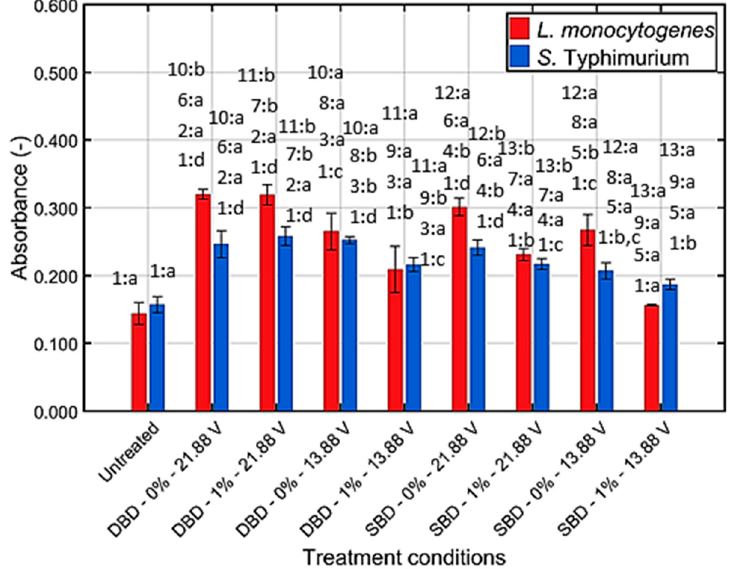
Figure 7. Absorbance measurements (-) obtained following CAP treatment of the Listeria monocytogenes and Salmonella Typhimurium model biofilms ( n = 3). Significant di ff erences between all examined conditions (ANOVA test 1), including the untreated control, have been indicated by means of a di ff erent small letter, with ‘a’ bearing the lowest value. The influence of the oxygen level (ANOVA tests 2–5), the electrode configuration (ANOVA tests 6–9), and the discharge power (ANOVA tests 10–13) have been indicated as well by means of a di ff erent small letter, with ‘a’ again bearing the lowest value. Separate ANOVA tests were again performed for each biofilm forming